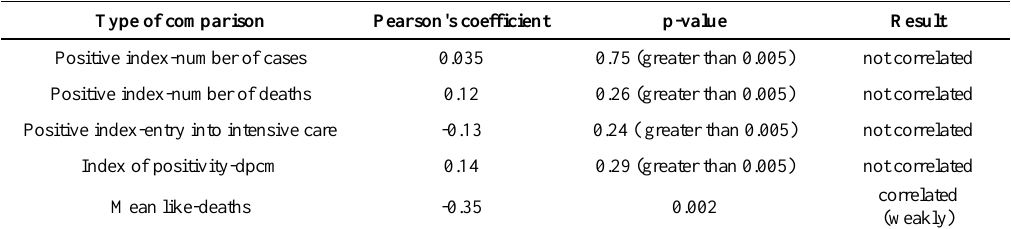
Table 12. Summary of the values of the comparisons made: Pearson's coefficient, p-value and the